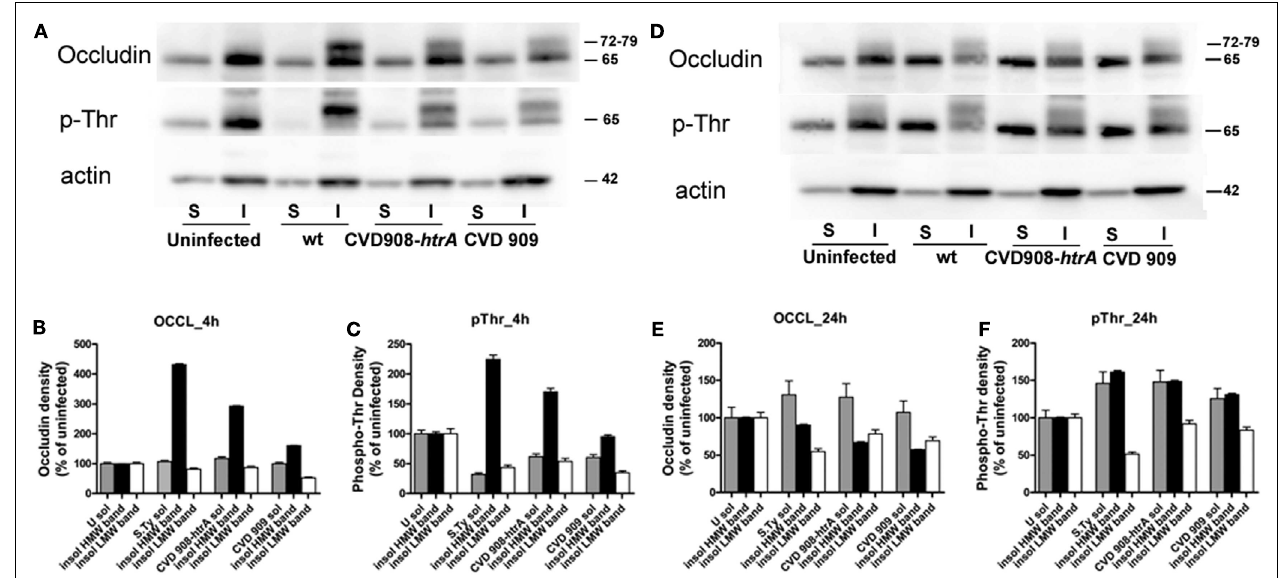
(upper panel), anti-phosphothreonine (middle panel), and anti-actin (lower panel) as loading control, 4h following exposure to bacteria. (B,C) Quantification of the data shown in (A) . (D) Western blot of protein samples blotted with anti-occludin (upper panel), anti-phosphothreonine (middle panel) and anti-actin (lower panel) 22h post-infection with S .Typhi strains. (E,F) . Quantification of the data shown in (D) . Data have been normalized to the actin loading control.These results represent the average of two individual